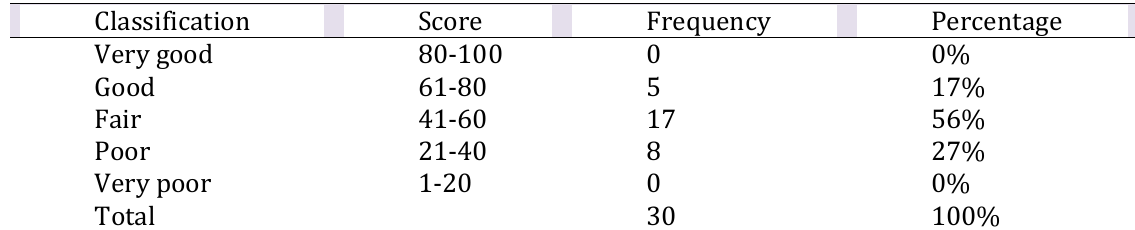
Table 4.2 the Rate Percentage Score from learners initial